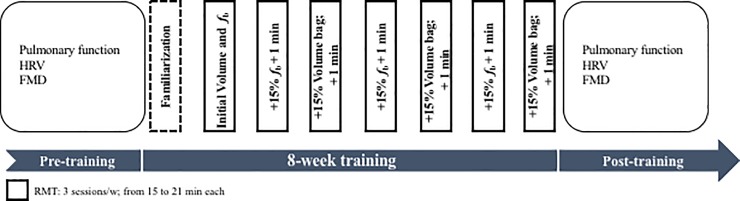
A schematic drawing of the study design.